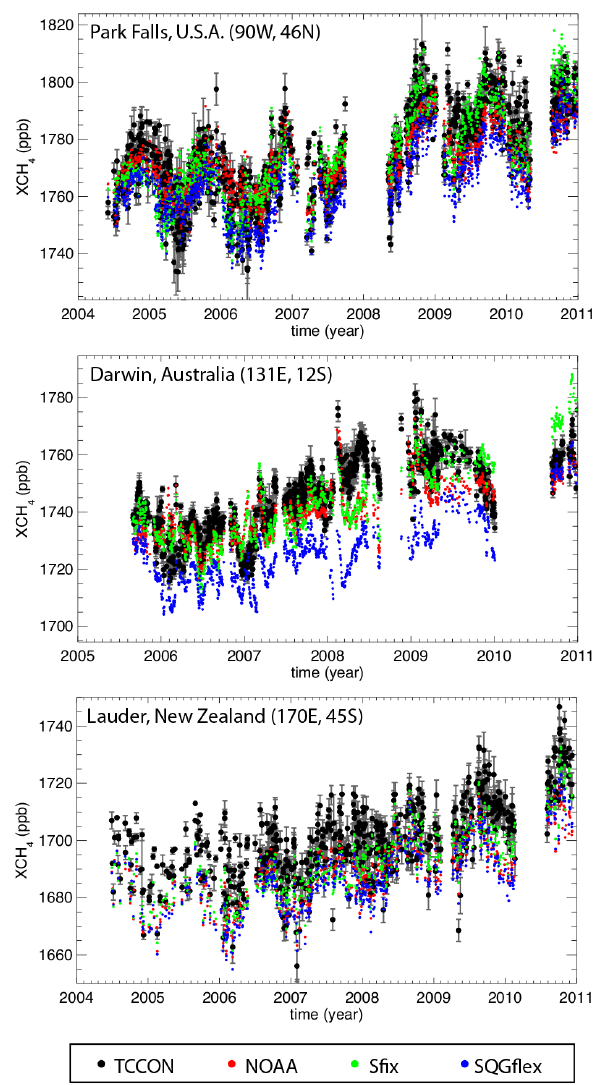
Fig. 6. Comparison between inversion-derived and TCCON- observed X CH 4 , at sites with multiple years of data. Black: TC- CON; red: NOAA inversion; green: S fix inversion; blue: SQG flex inversion. Error bars represent the standard deviation of the plotted diurnal